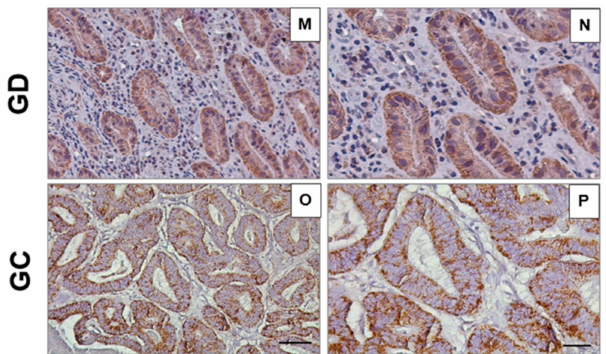
Figure 2. Representative images of immunohistochemical detection of Hsp60 in biopsies of human gastric tissue: ( A , B ) normal mucosa (NM), ( C , D ) mild-to-moderate gastritis (MMG), ( E , F ) severe gastritis (SG), ( G , H ) hyperplastic polyp (HP), ( I , L ) intestinal metaplasia (IM), ( M , N ) gastric dysplasia (GD), ( O , P ) gastric adenocarcinoma (GC). ( A , C , E , G , I , M , O ) Magnification 200 × , scale bar 50 µ m. ( B , D , F , H , L , N , P ) Magnification 400 × , scale bar 20 µ m. Details of the normal mucosa, intestinal metaplasia, and gastric carcinoma with increasing numbers of Hsp60-positive cells (see percentages above) are shown in Figure 3.